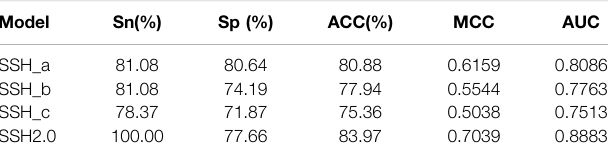
TABLE 2 | The prediction performance of three sub-models evaluated through leave-one-out cross-validation and that of the ensemble model evaluated through voting strategy.